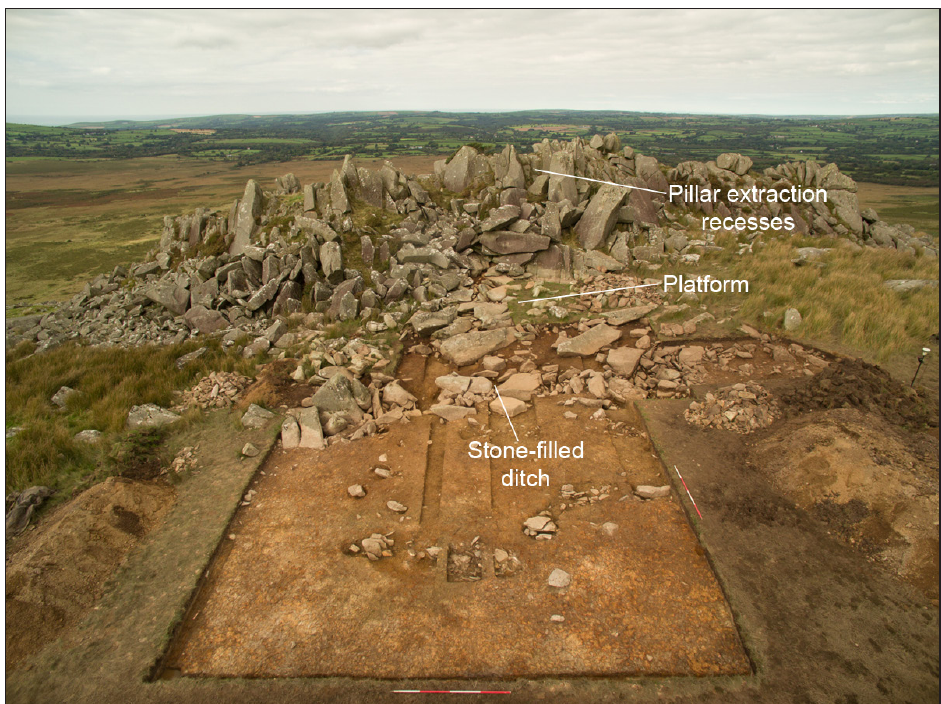
Figure 2: Excavations at Carn Goedog, viewed from the South, showing the outcrop, the Neo- lithic platform and the stone-filled Neolithic ditch (Photo Adam